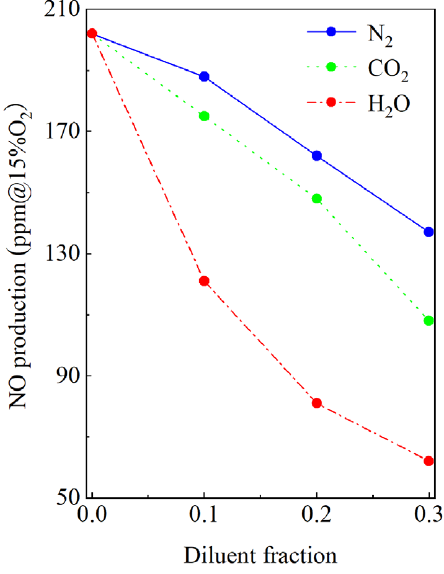
Figure 8. Variation in the NO production with the diluent fraction.